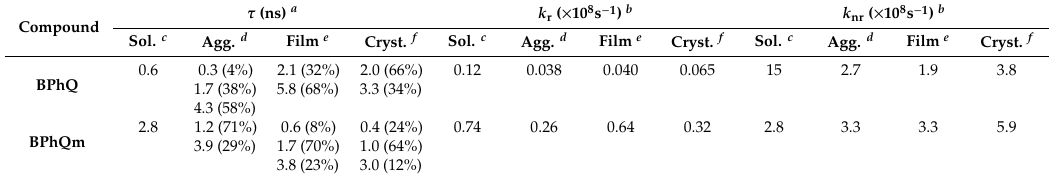
Table2. Fluorescencelifetimeandradiativeandnon-radiativerateconstantsofthesynthesizedcompounds. τ (ns) Compound